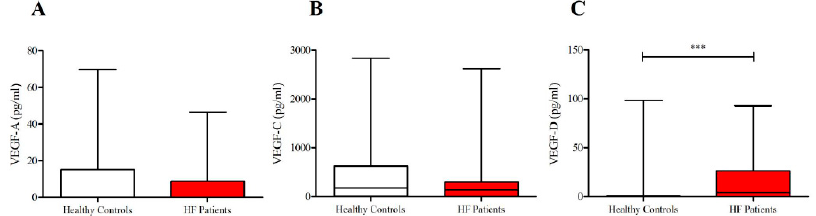
Figure 2. ( A ) Plasma concentrations ofvascular endothelial growth factor-A (VEGF-A) in heart failure (HF) patients and in healthy controls; ( B ) plasma concentrations of VEGF-C in HF patients and in healthy controls; ( C ) plasma concentrations of VEGF-D in HF patients and in healthy controls. Data are shown as the median (horizontal block line), the 25th and 75th percentiles (boxes), and the 5th and 95th percentiles (whiskers) (statistical analysis was performed by a Student’s t -test). *** p < 0.001.